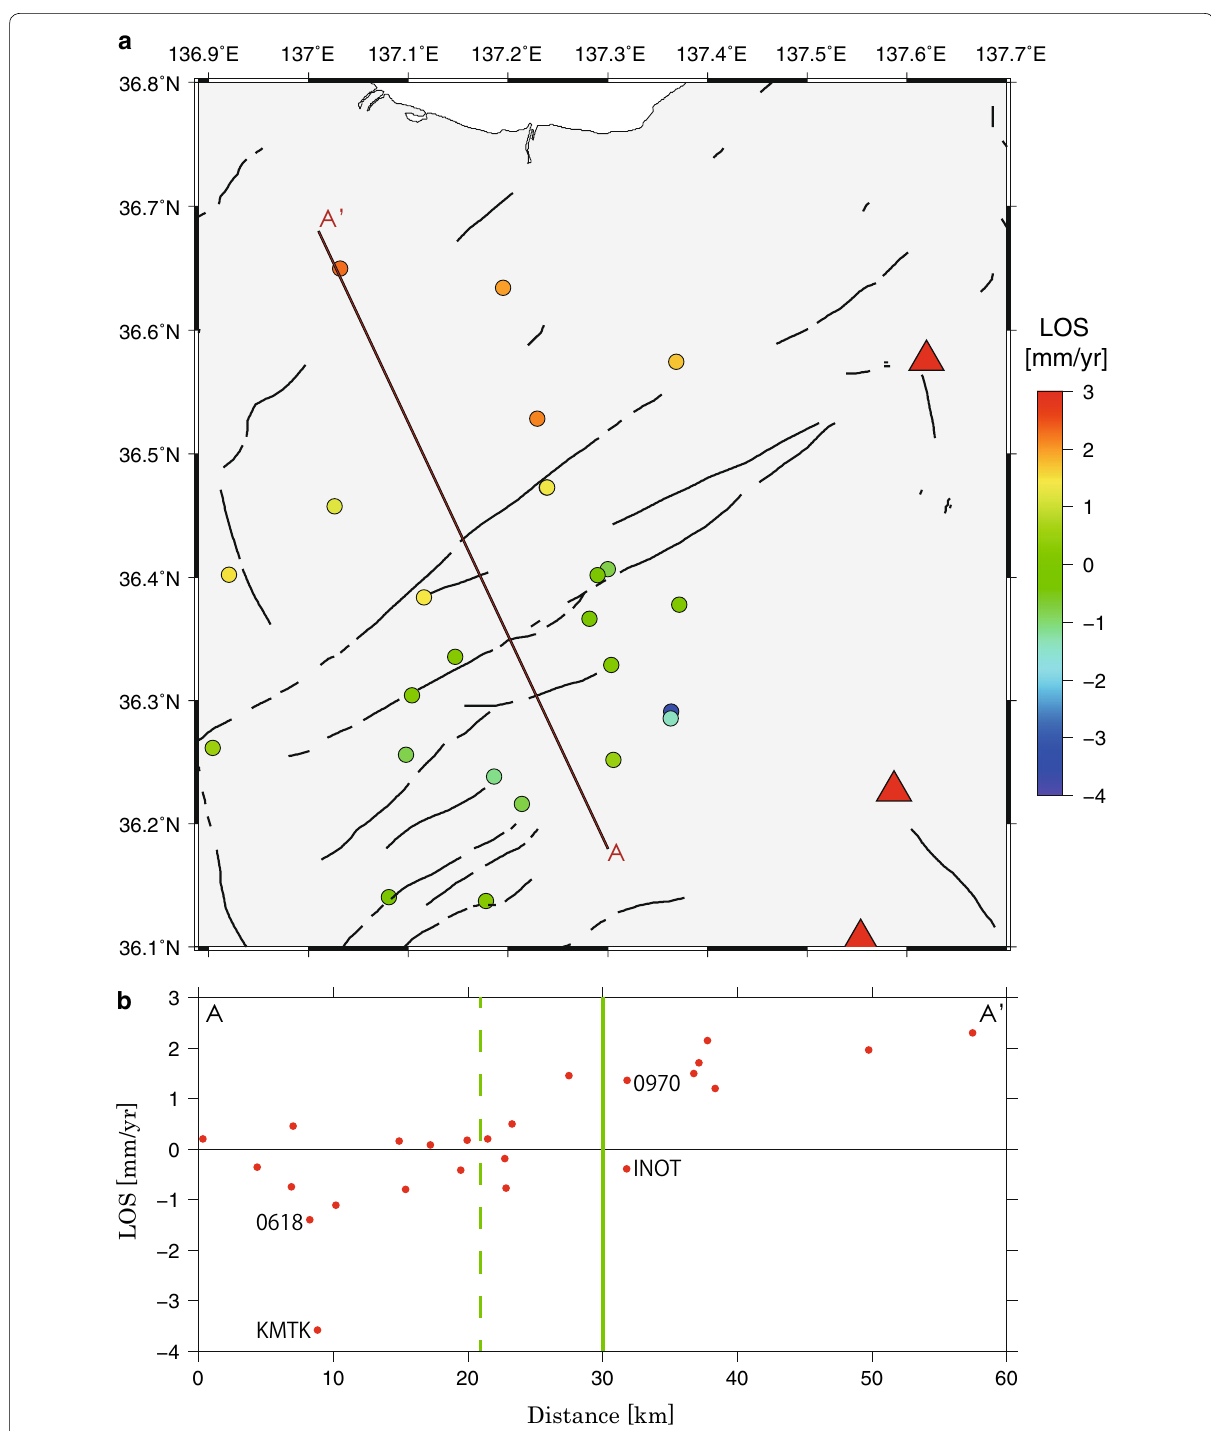
Fig. 9 a LOS velocities calculated from GNSS data. Red triangles indicate active volcanoes. b One-dimensional profile of the GNSS-derived LOS velocities. The profile is indicated by the red line (AA’) in a , which is the same as AA’ in Fig. 7. Green solid and broken lines at ~ 30 and ~ 21 km along the horizontal axis indicate the locations of the Ushikubi and Atotsugawa faults,